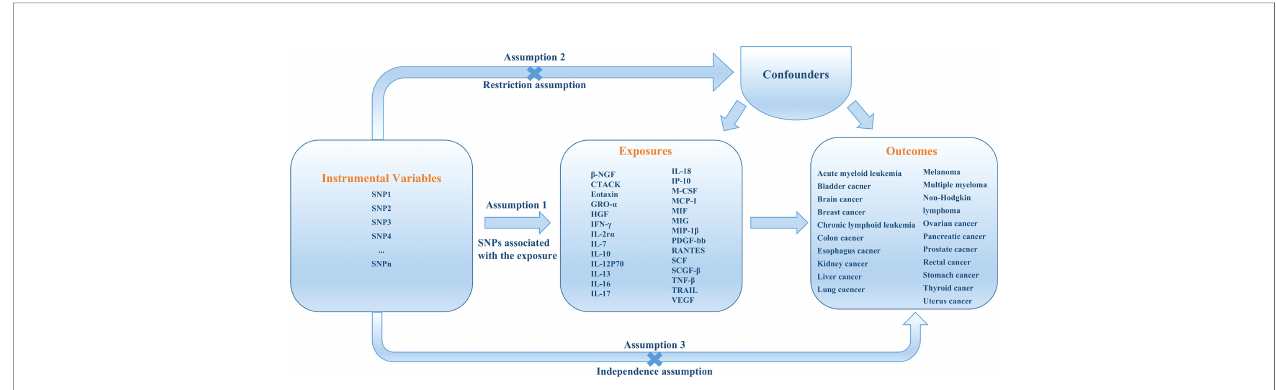
FIGURE 1 | An overall design of the present